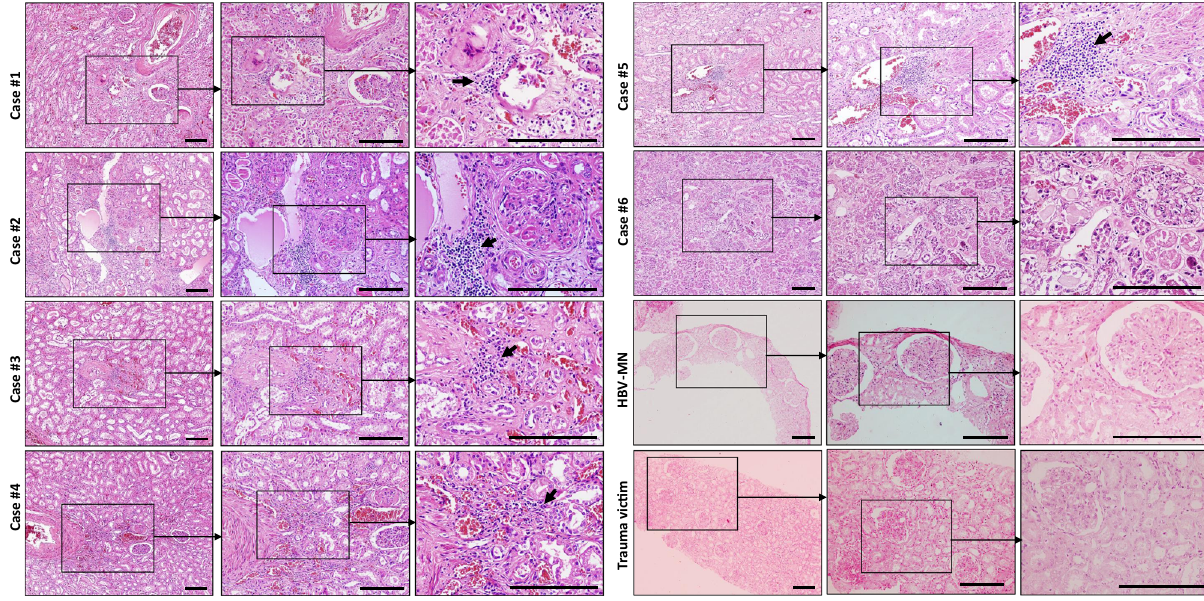
Fig. 1 The histopathology of kidney tissues from COVID-19 post-mortem. Sections from six cases of COVID-19 post-mortem, one representative hepatitis B virus-associated membranous nephropathy (HBV-MN) patient and one representative trauma victim were collected to stain by haematoxylin & eosin (H&E). Arrow indicates in fi ltrated leukocytes. Scale bars = 200 μ m. Data represent one of at least three technical replication